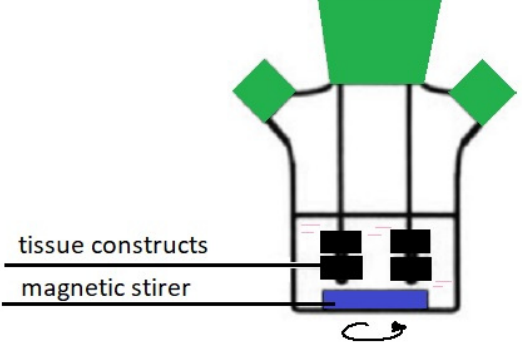
Figure 7. Spinner Flask bioreactor.